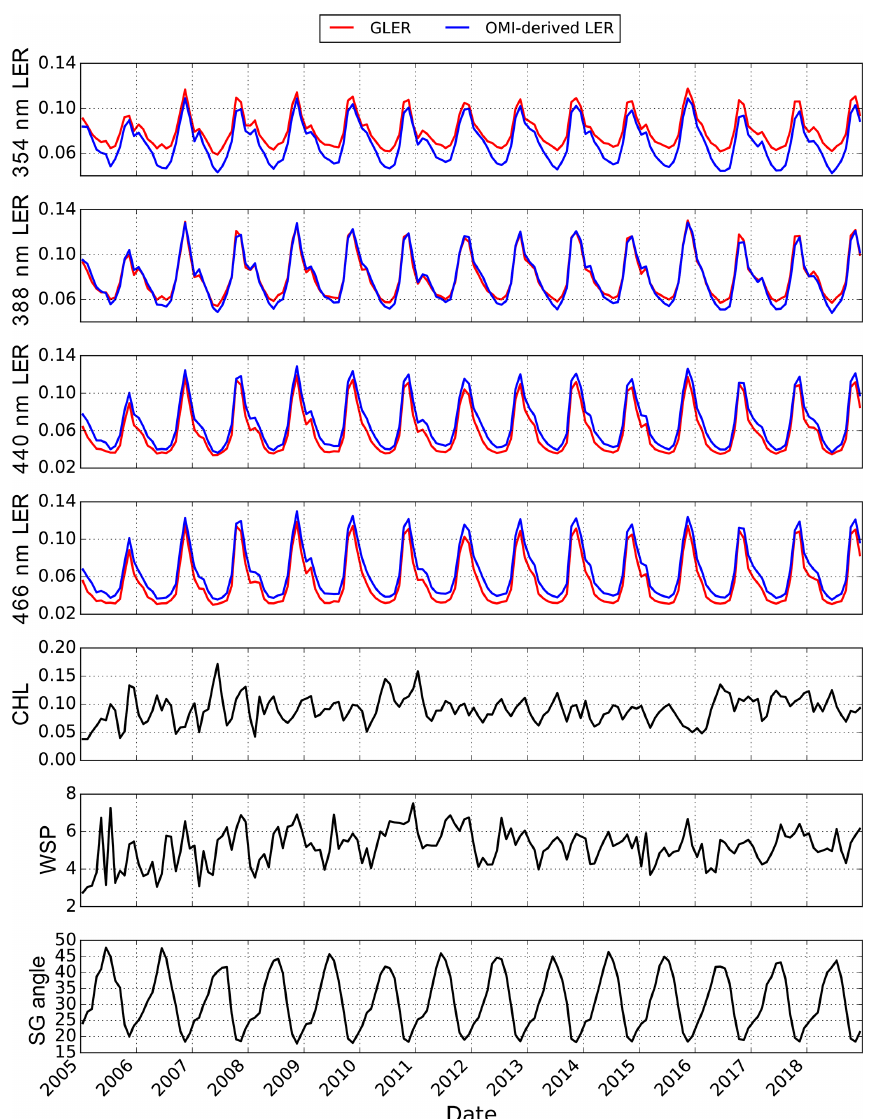
Figure 9. Monthly mean of GLER and OMI-derived LER in the equatorial Pacific Ocean (180–120 ◦ W, 30 ◦ S–0) for four wavelengths (354, 388, 440, and 466nm) as a function of time for the OMI mission from row 10. Corresponding chlorophyll and wind speed measurements along with sunglint angle used for GLER are shown in the bottom three panels. Data are filtered to remove clouds with the Raman-based